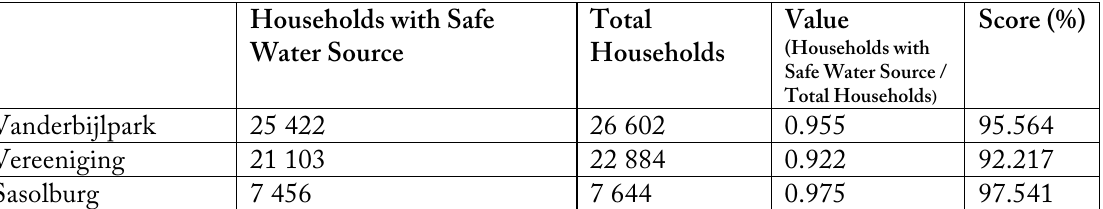
Table 3 Access component